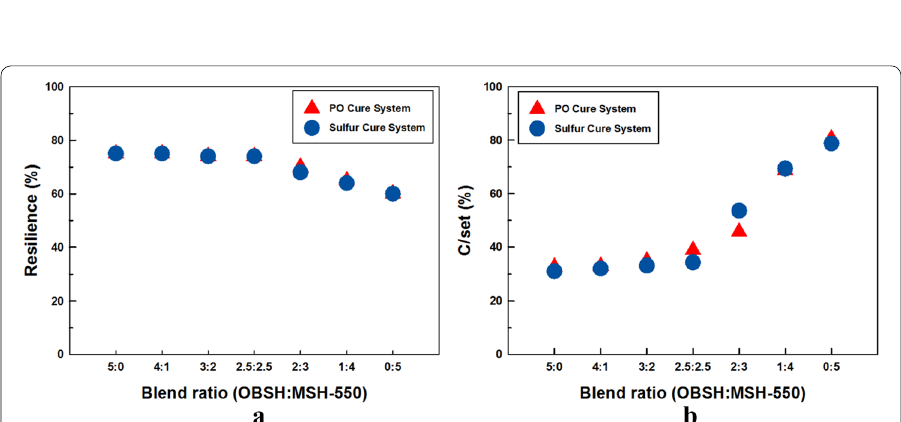
Fig. 5 Resilience ( a ) and compression recovery ( b ) of bio‑EPDM foam depending on the mixing ratio of blowing